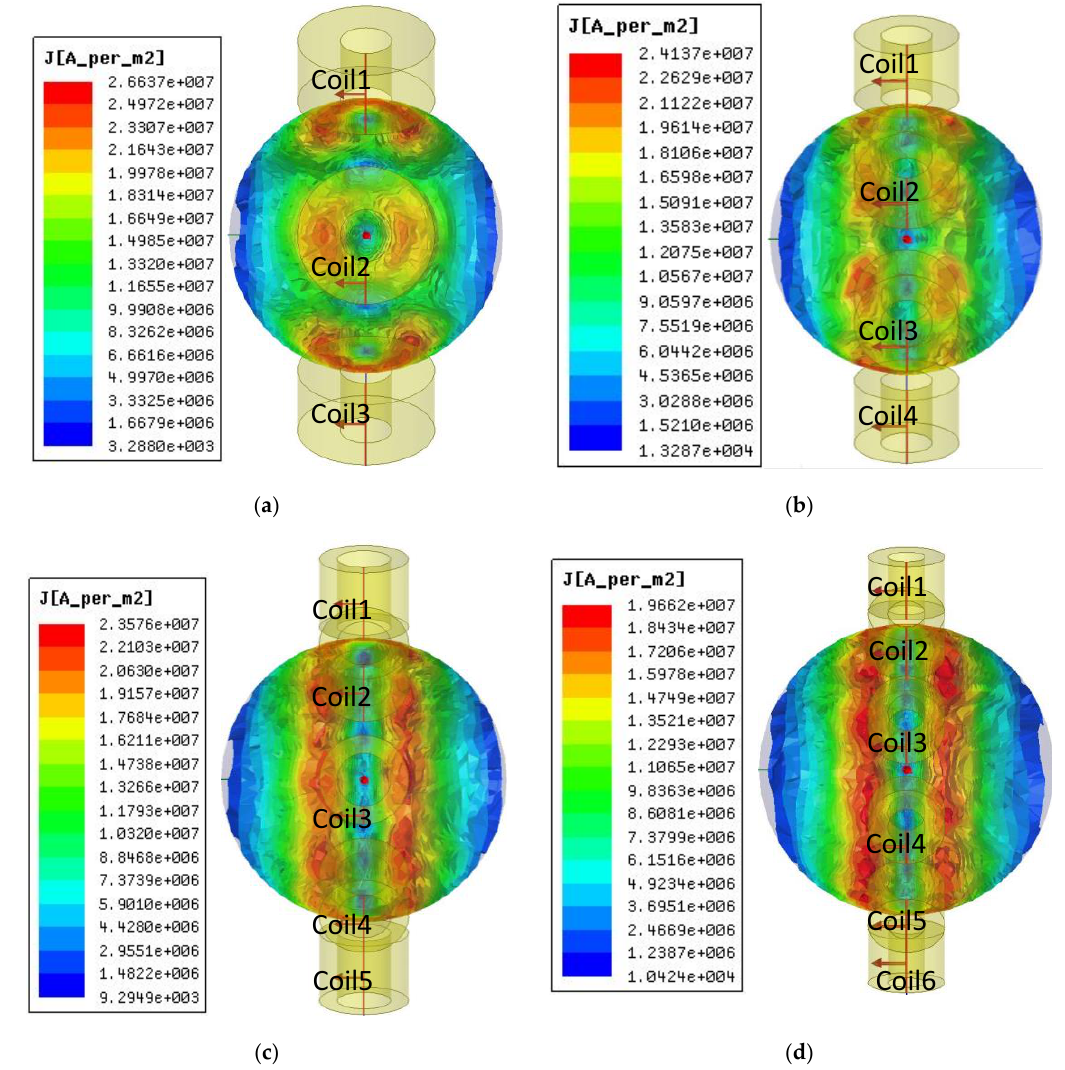
Figure 7. Eddy current density distributions of multi-coil probes in a CECA sensor on steel ball surfaces. The eddy current density distribution on a steel ball surface induced by ( a ) 3-coil probe; ( b ) 4-coil probe; ( c ) 5-coil probe; ( d ) 6-coil probe.